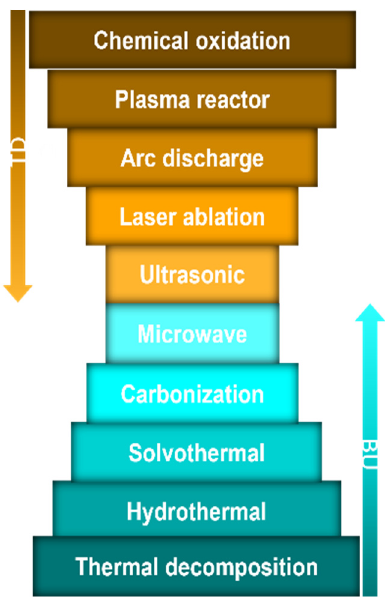
Figure 2. Synthesis of carbon dots: top-down (TD) and bottom-up (BU) approaches.